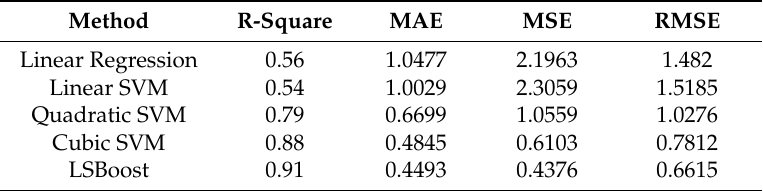
Table 4. Comparison of existing methods for the daily forecast.